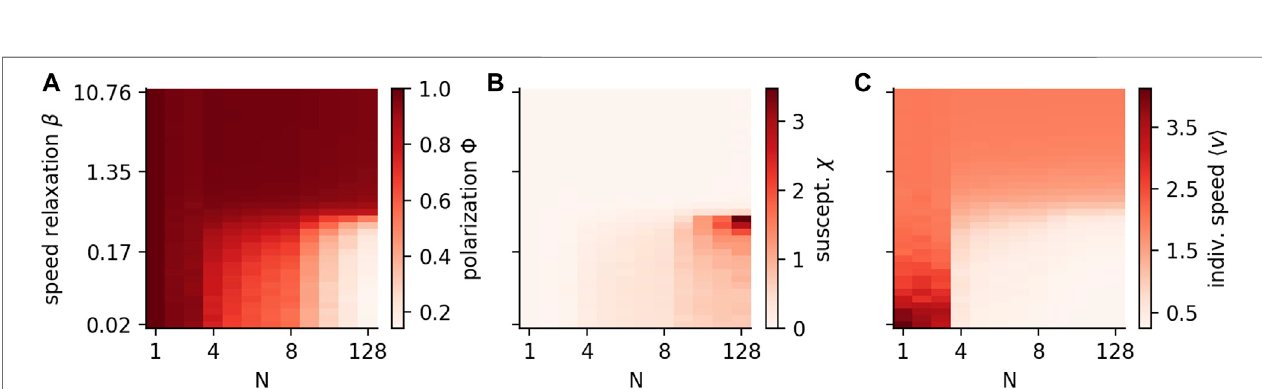
FIGURE 4| Variable speed affects collective behavior in different states. Polarization Φ (A) , the susceptibility χ (inset A ),the individual speed 〈 s 〉 (B) , the area of the convex hull (C) and the nearest neighbor distance NND (inset C ) areshown in dependence on thevelocityalignmentstrength μ alg .Black crosses (B,C) mark thepeak of the susceptibility, i.e. the location of the phase transition. The lines are color coded according to the speed relaxation as indicated at the colorbar, i.e. β ∈ {1, 2, 4, 8, 16, 32, 64}. The parameters of the simulations are listed in Table 2 ; Supplementary Table S5 .